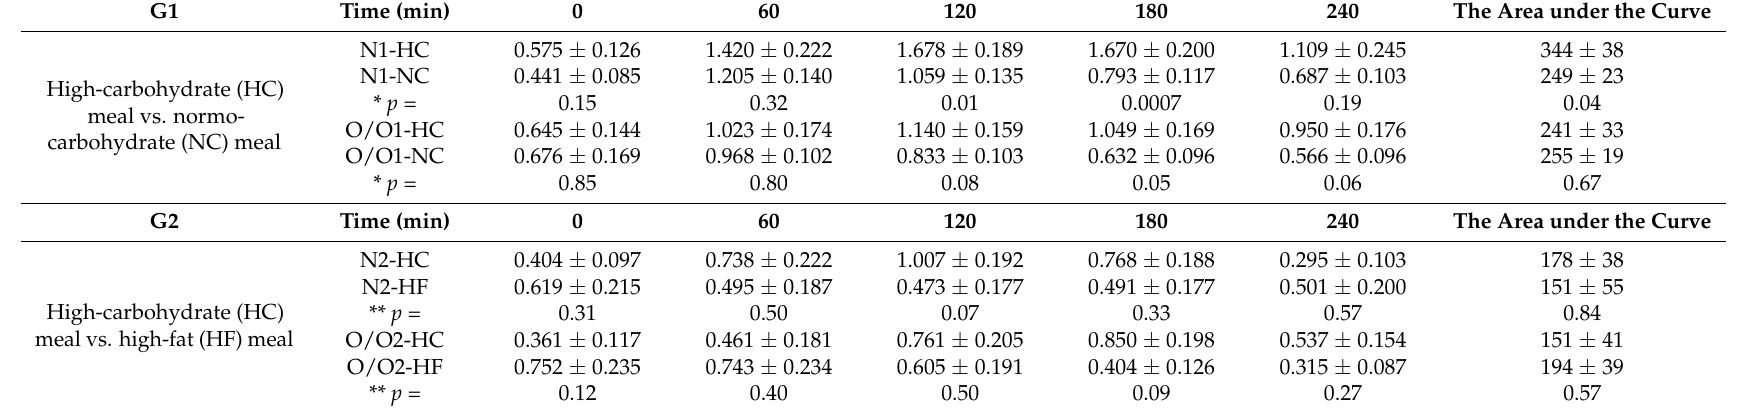
High-carbohydrate